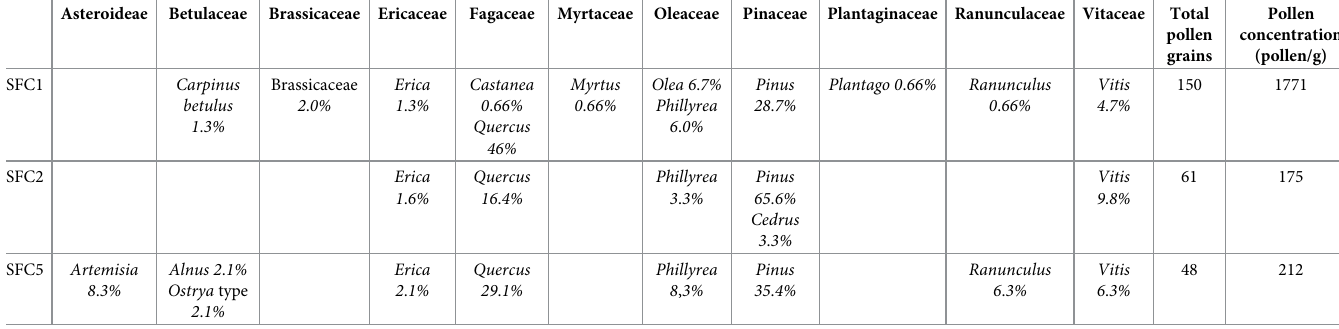
Table 1. Pollen grains recovered from the analyses of amphorae SFC1, SFC2 and SFC5. Asteroideae Betulaceae Brassicaceae Ericaceae Fagaceae Myrtaceae Oleaceae Pinaceae Plantaginaceae Ranunculaceae Vitaceae Total